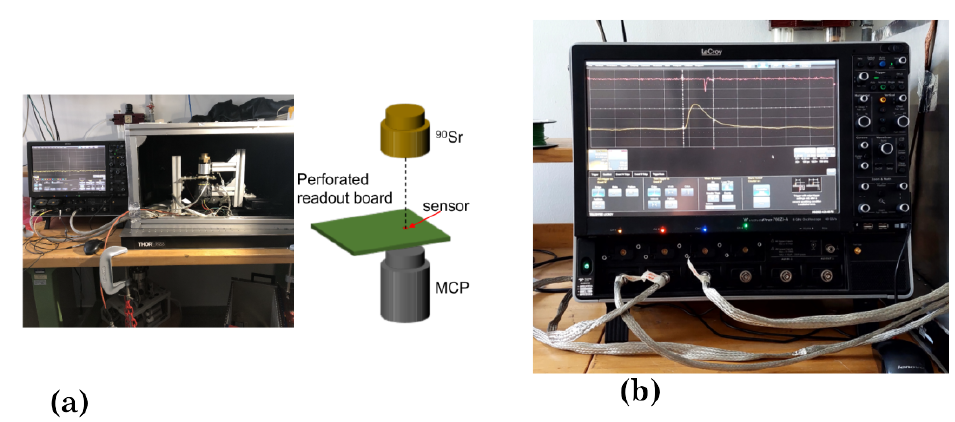
Figure 3. Laboratory setup for timing measurements. ( a ) Overview with a schematic of the aligned system of excitation (a beta source) and triggering (MCP-PMT). ( b ) Detail of the measurement: signals from the diamond test structure and the reference, displayed by the oscilloscope.